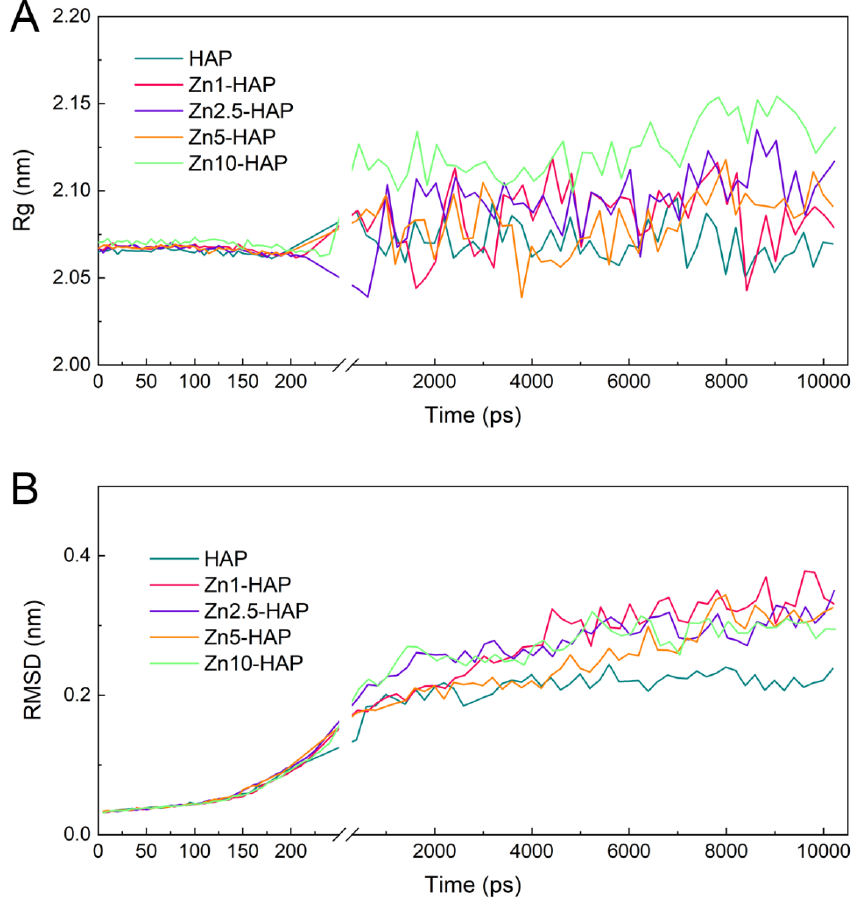
Figure 4. Rg ( A ) and RMSD ( B ) of BMP-2 upon HAP/Zn-HAPs during the binding and adsorption processes.